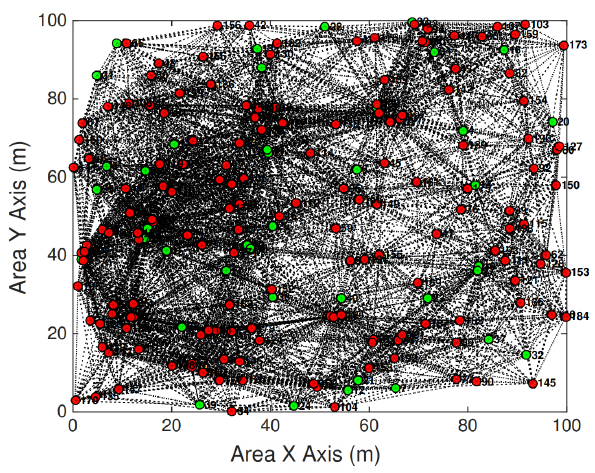
Figure 4. An example network topology generated in MATLAB with 40 beacons and 160 unknowns in a 100 m × 100 m area.